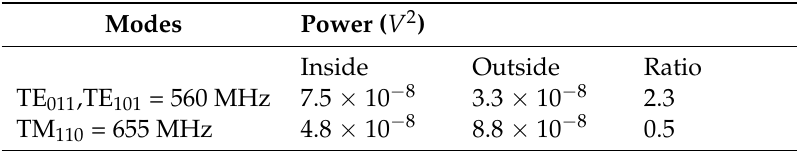
Table 9. Peak values for first TE and TM modes inside and outside the tank for surface PD on